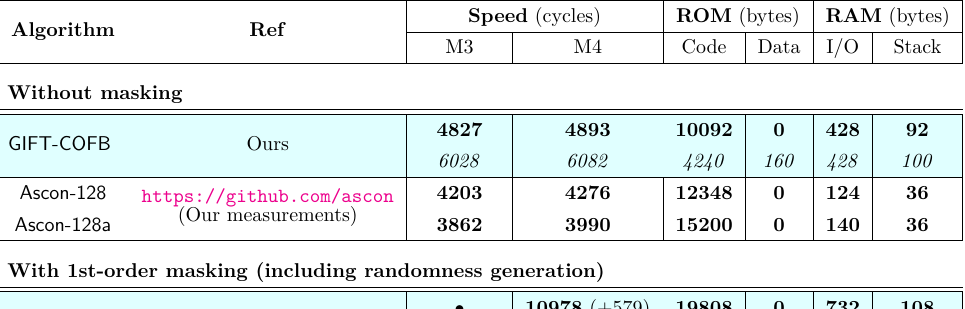
Table 6: Constant-time implementation results on ARM Cortex-M3 and M4 for GIFT- COFB and Ascon to secure 16 bytes of message along with 16 bytes of additional